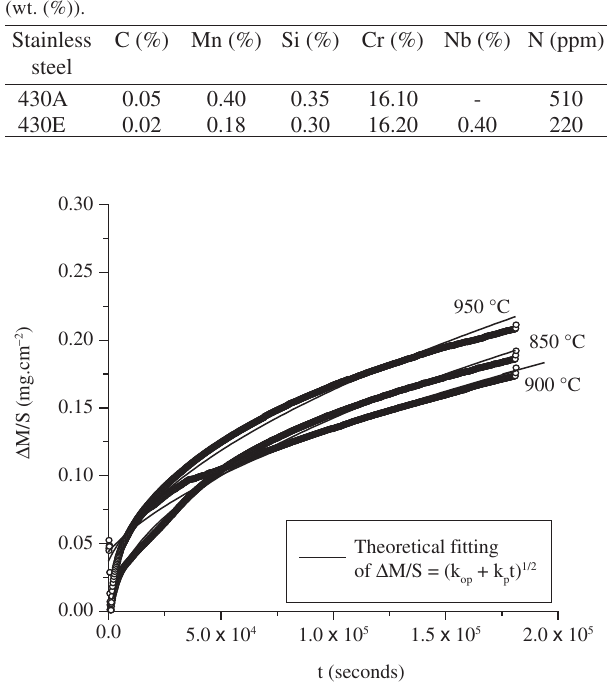
Figure 1. Thermogravimetric analysis for the oxidation of the 430A steel in Ar/H /H O. 2 2